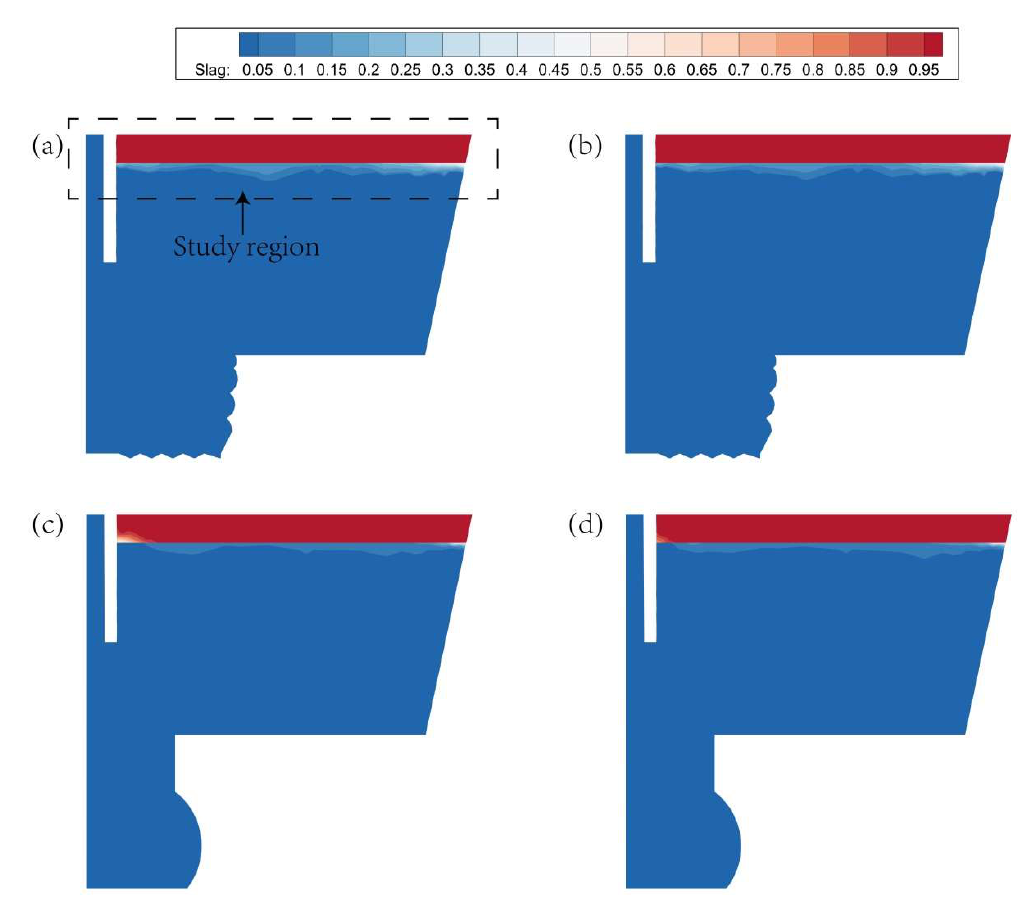
Figure 10. The slag fraction contours of case 1 at ( a ) 825 s and ( b ) 830 s; the slag fraction contours of case 2 at ( c ) 825 s and ( d ) 830 s.